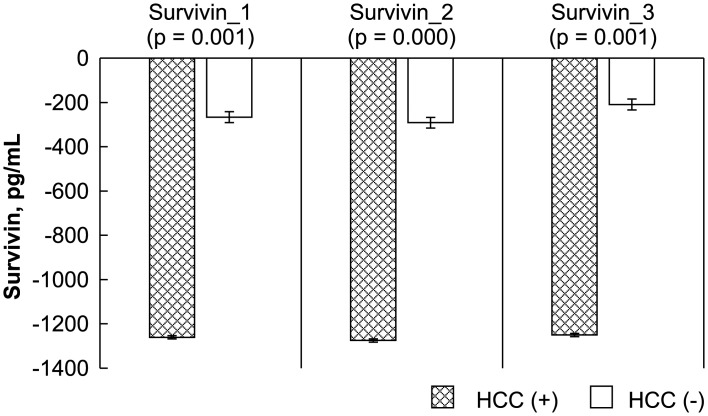
Statistical analysis of FGF-2, survivin, Ki67, endostatin, and VEGF levels, as measured by ELISA before (_1), early after (_2), and late after (_3) after living donor liver transplantation (LDLT).The Mann-Whitney U test was used to compare the differences in the biomarkers at the various time points between the recipients with and those without HCC recurrence.